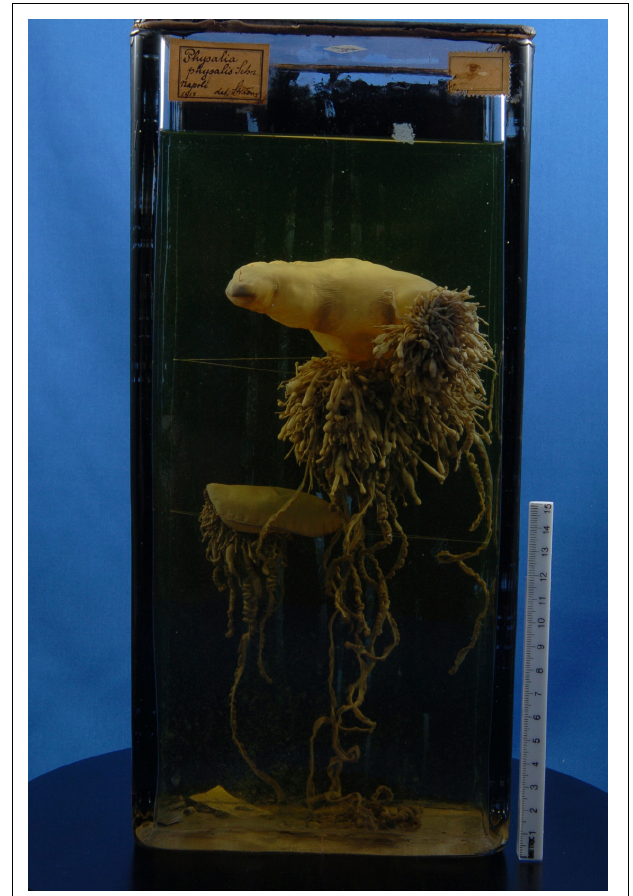
(Italy) in 1914, preserved at the “Darwin Dohrn” Museum of Naples (photo by Akira Kihara, Science Center, Hosei University, Tokyo; ©2007 Zoological Collection Database Stazione Zoologica “Anton